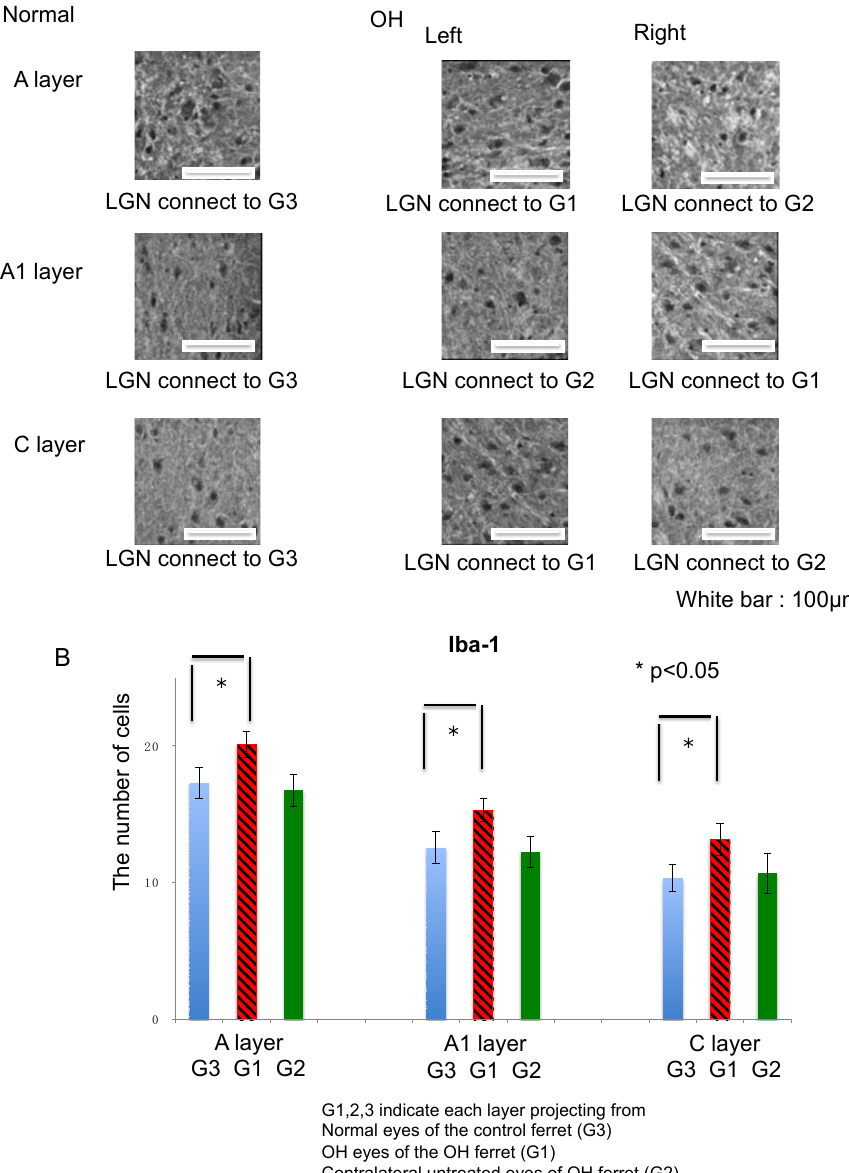
Figure 6. Immunohistological images of neuroglial cells in LGN of the OH (G1) and the untreated contralateral eyes (G2) of the OH ferret, and the normal eyes (G3) of the control ferret. ( A ): Iba ‐ 1 staining indicating microglia. (200 μ m × 200 μ m square; white bar = 100 μ m). Comparison of neuroglial cells in LGN layers projecting from the OH (G1) and the untreated contralateral eyes (G2) of the OH ferret, and the normal eyes (G3) of the control ferret. ( B ): The number of Iba ‐ 1 immunoreactive microglial cells. A significant increase of the number of Iba ‐ 1 ‐ immunoreactive cells was observed in A, A1, and C layers of G1, compared with those of G3 ( n = 10, paired t ‐ test, p < 0.05). The number of Iba ‐ 1 ‐ positive cells in the A, A1, and C layers of the LGN in the normal and OH ferrets were calculated to investigate microglial activation in the LGN (OH period, 13 weeks; OH, n =10; normal, n = 6). In the LGN of OH ferrets, a remarkable increase of Iba ‐ 1 immunoreactivity was observed, with strongly stained cell bodies. Iba ‐ 1 ‐ immunoreactive cells showed similar spatial and temporal distribution patterns to Iba ‐ 1 immunoreactivity in the control and glaucomatous LGN, and immunoreactivity was significantly elevated in the glaucomatous layers. Significantly increased Iba ‐ 1 immunoreactivity was observed in the A, A1, and C layers projecting from OH eyes (G1) compared with those from the untreated eyes (G2) and the normal eyes (G3; unpaired t ‐ test, p < 0.05; Figure 6B). The number of Iba ‐ 1 ‐ positive cells in each LGN layer was compared between normal and OH ferrets, and the rate of change compared with normal ferrets was calculated. The numbers of Iba ‐ 1 ‐ positive cells were increased by 16.2% in left A, 22.1% in right A1, and 27.5% in left C layers, which were projected from the right OH eye (G1), compared with that in the eyes of normal ferrets (G3). The numbers of Iba ‐ 1 positive cells increased by − 3.2%, − 2.3%, and 3.3%, respectively, in the right A, left A1, and right C layers, which were projected from the untreated eyes (G2). This increase in the number of Iba ‐ 1 ‐ positive cells was prominent in the C layer projected from the right OH eye (G1). Moreover, there was a marked decrease in the number of neurons in the C layer, suggesting that the neuronal damage and reactive glial response were the most severe in the C layer (Table 1). 3. Discussion